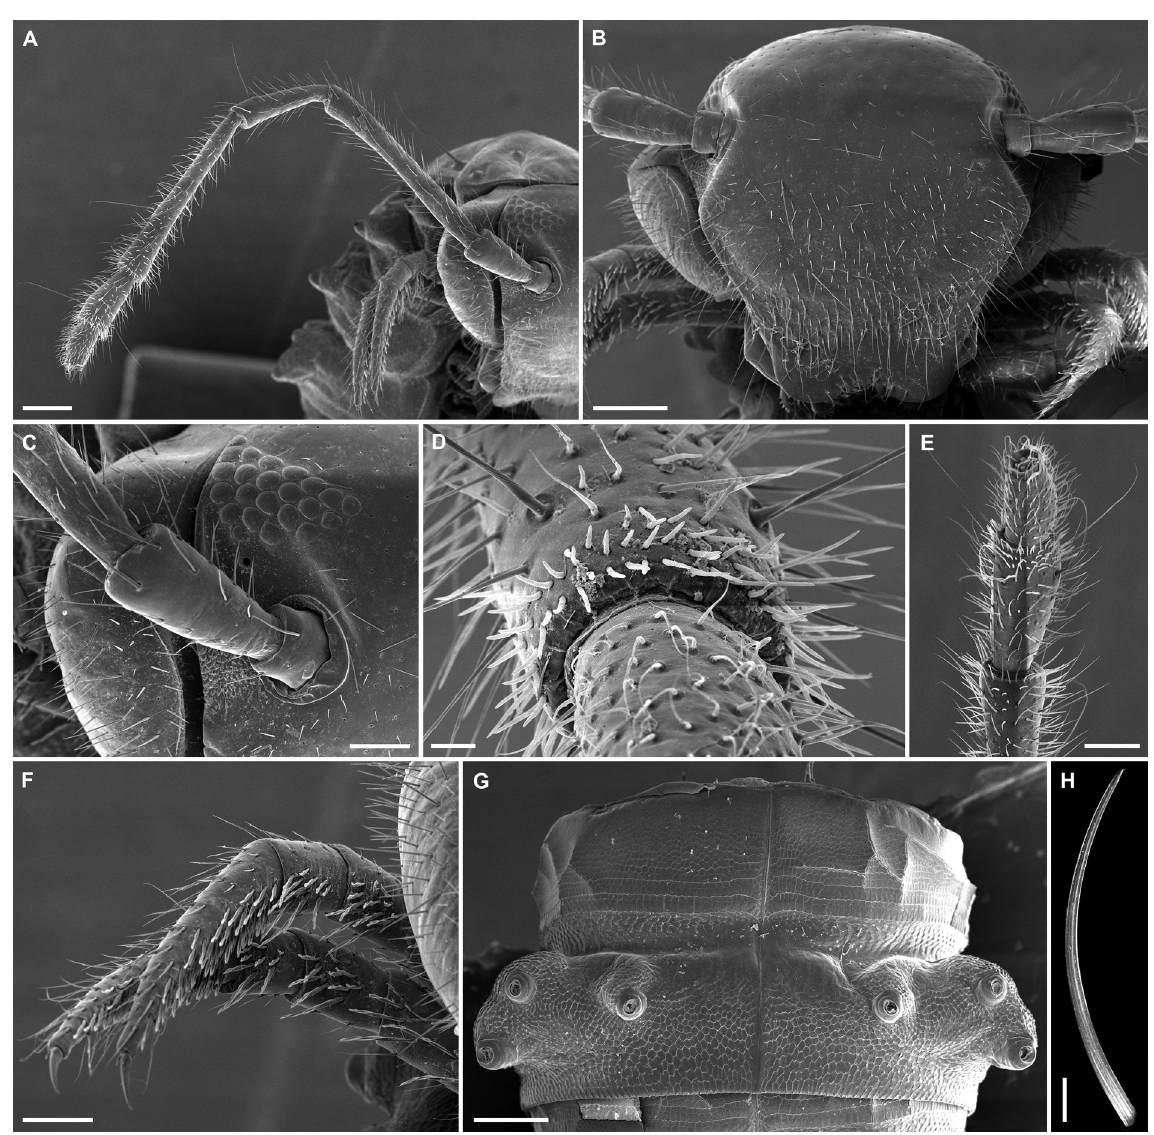
Fig. 3. Caucaseuma strasseri Antić sp. nov., paratype, ♂ (NHMW MY10260). SEM images of some habitual structures. A . Anterior part of the body, anterolateral view. B . Head, anterior view. C . Head, right side, lateral view. D . Left antennomeres 6 and 7, detail. E . Tip of right antenna. F . Right legs 1 and 2, anteroventral view. G . Ring 15, dorsal view. H . Posterior macrochaeta. Scale bars: A–B, G = 0.2 mm; C, E–F = 0.1 mm; D = 0.02 mm; H = 0.05